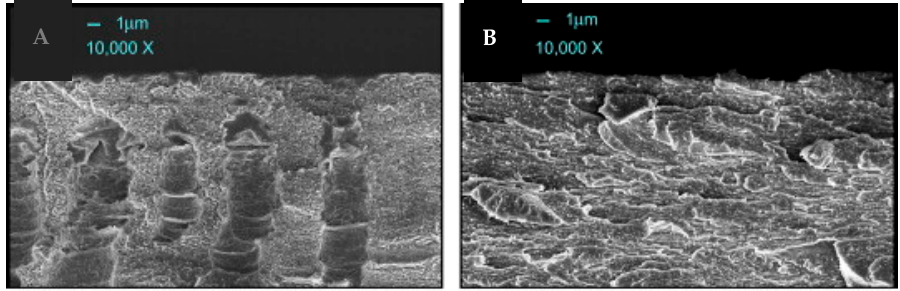
Figure 2. SEM images showing membrane cross-sections of MIM (A) and NIM (B) prepared via phase inversion technique. Reproduced with permission [23].